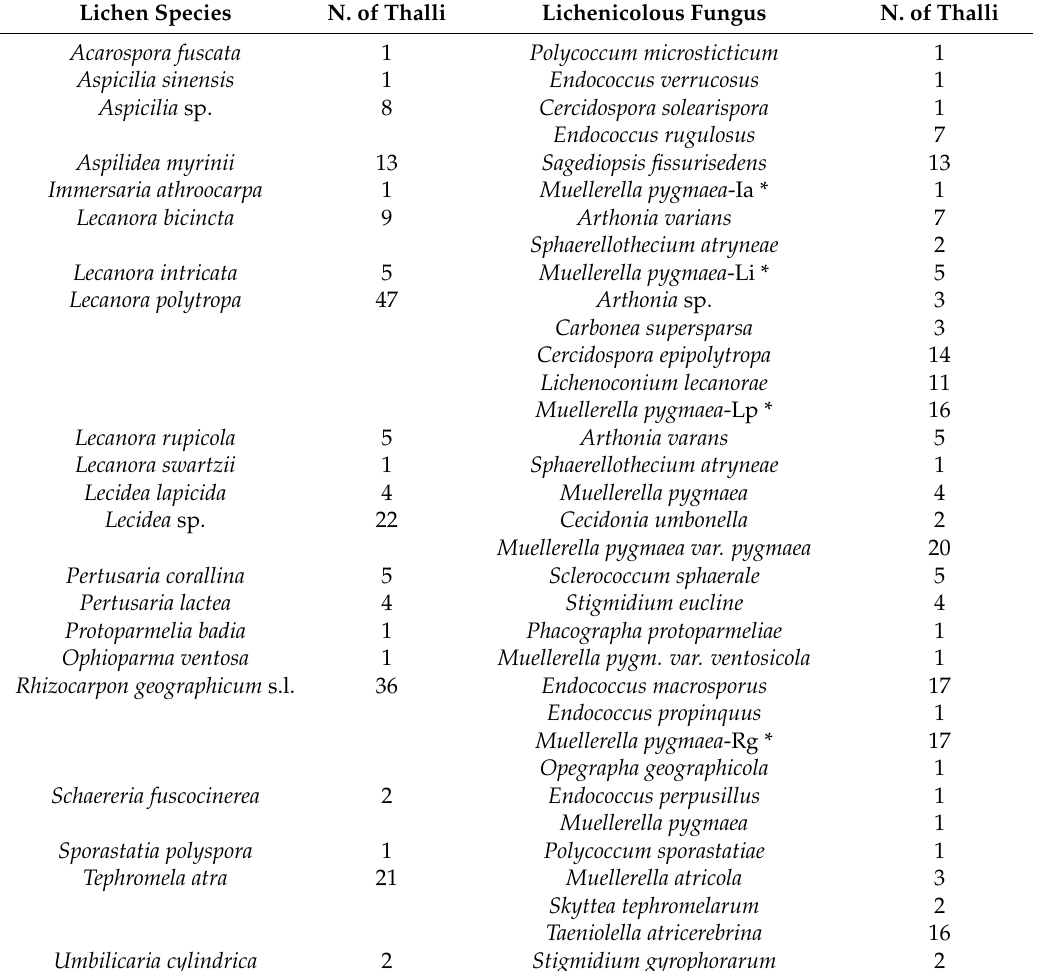
Lichens and lichenicolous fungal species and the number of thalli used in the culture